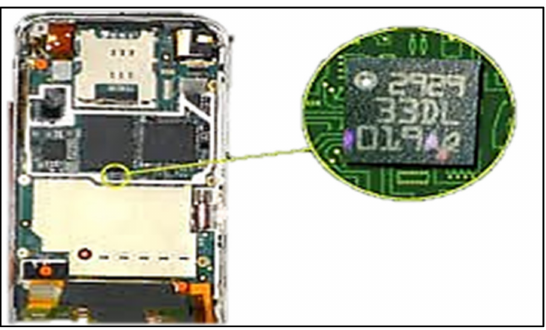
Figure 4. A typical accelerometer used in a smartphone.